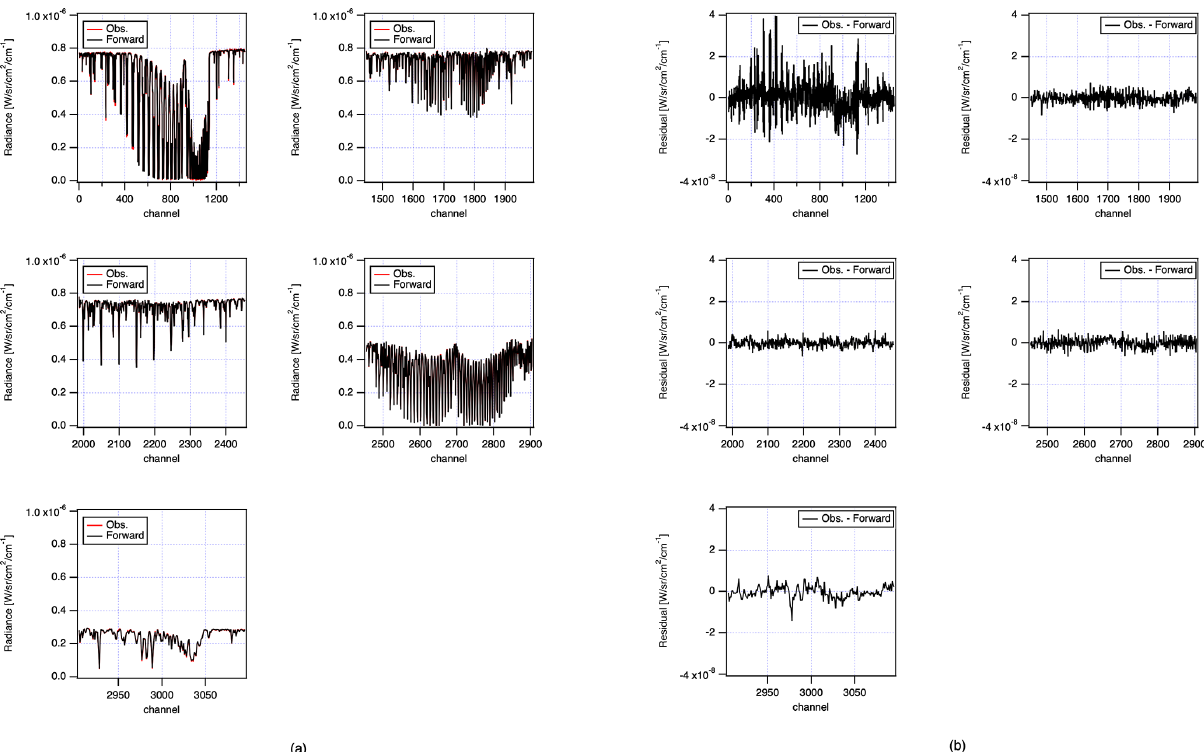
Figure 18. An example of residual spectra between observed and forward calculated over vicarious calibration site (RRV) on 1 July 2019. (a) Difference between the observed spectra and the forward calculation for each window. (b) The residual between the observed spectra and the forward calculation for each window.